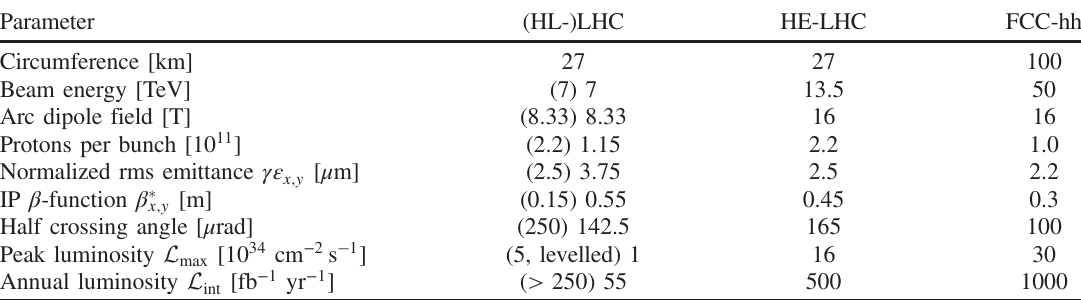
TABLE I. Nominal parameters for (HL-)LHC, HE-LHC and FCC-hh for proton operation.